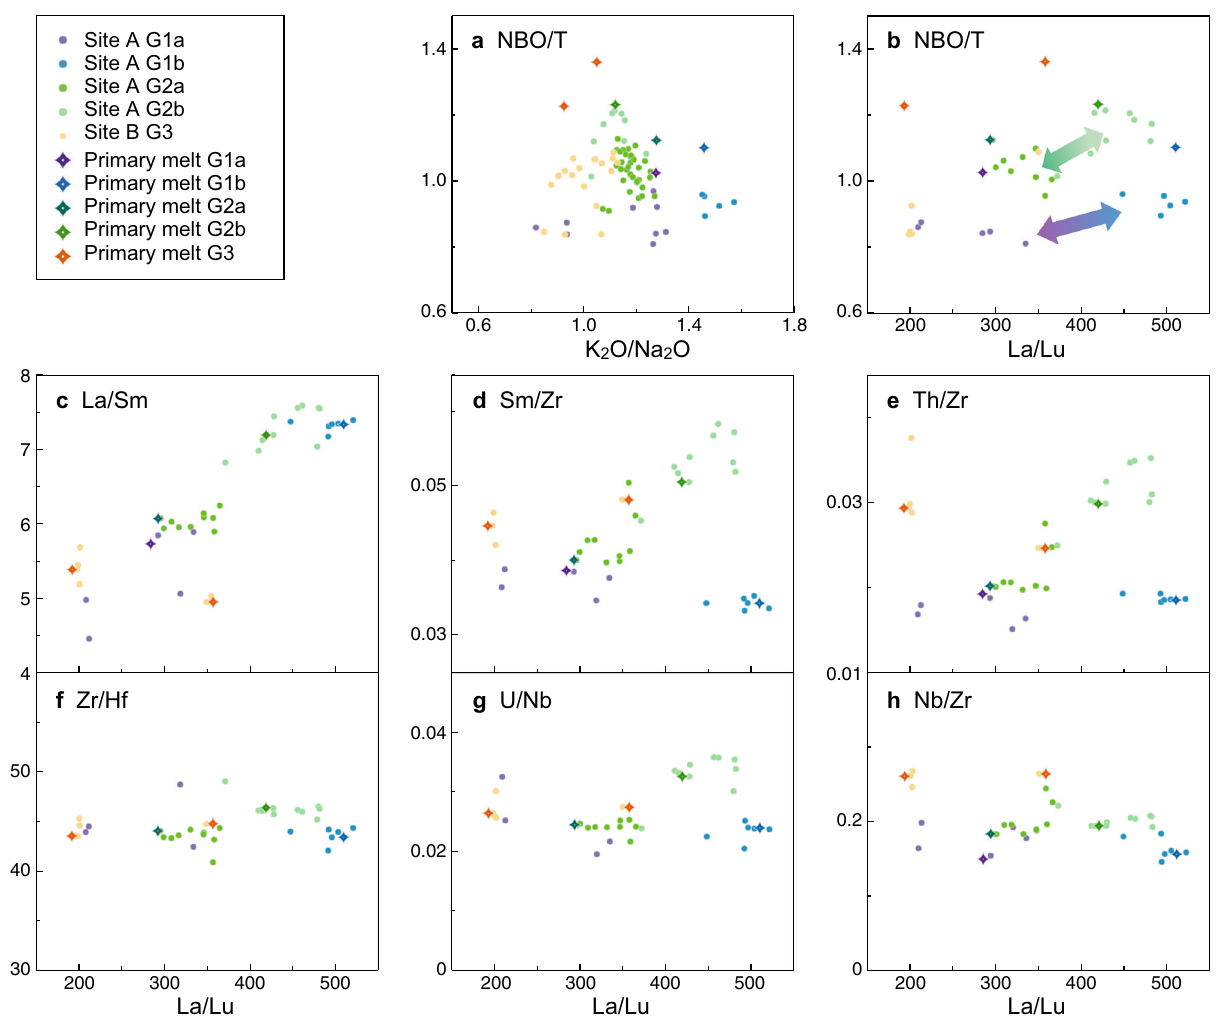
Fig. 6 Variations of elemental ratios and NBO/T to be key of veri fi cation for trace-element partitioning by carbonatite – silicate immiscible melt separation. Diagrams show a correlation between Alkalinity (K 2 O/Na 2 O) ( a ) or La/Lu ( b ) and the degree of polymerization (NBO/T), and the trace- element ratios ( c – h ) of the primary magma calculated in this study and for the actual primitive petit-spot basalt samples from Site A 31 . Compositions of the “ Primary melts ” for each subgroups of G1 and G2 basalts and trace element compositions of G3 basalts were calculated on the basis of the actual samples as listed in Supplementary Table 1. Major element composition of the “ Primary melts ” for G3 basalts are from Machida et al. 55 . The thick arrows in ( b ) show the positive correlations in G1 and G2 basalts, respectively. The numerator of each trace-element ratio corresponds to the element with a lower ionic potential and the denominator to a higher ionic potential. The NBO/T was calculated on the basis of the strategy proposed by Mysen and Richet 77